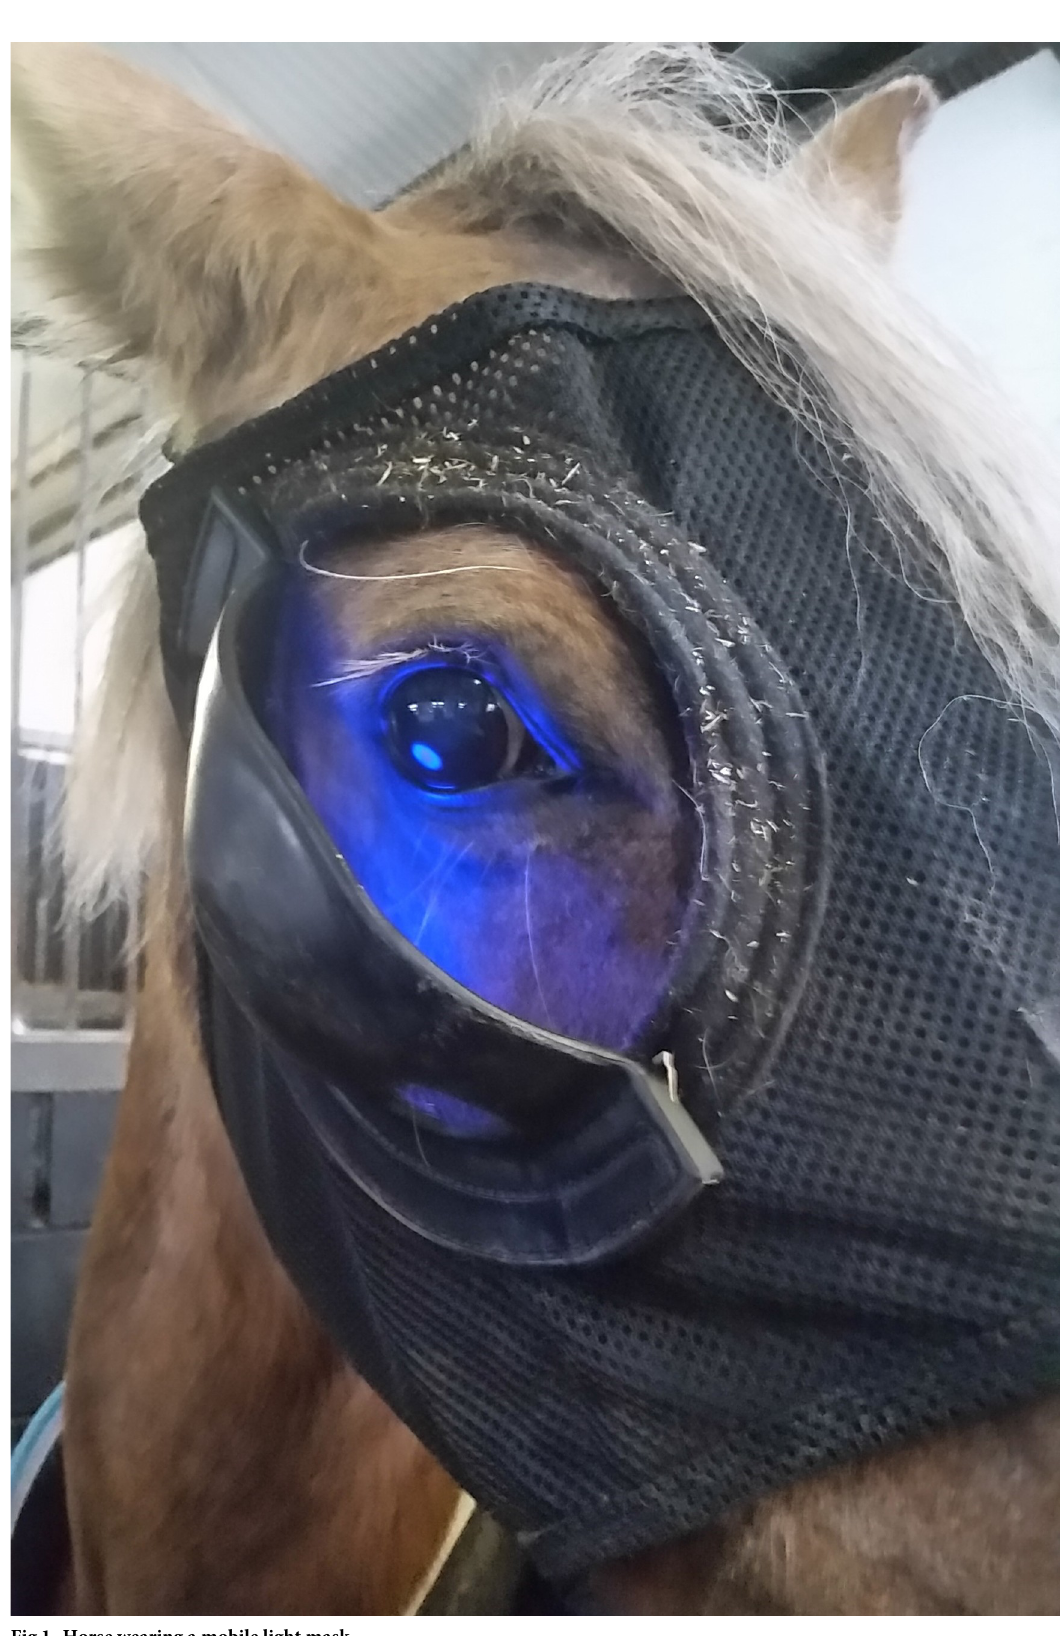
Fig 1. Horse wearing a mobile light